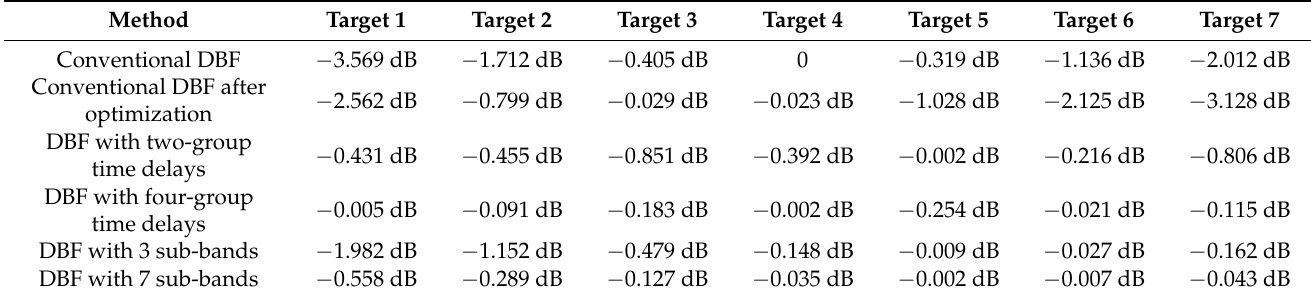
Table 2. PEL of simulated point targets.